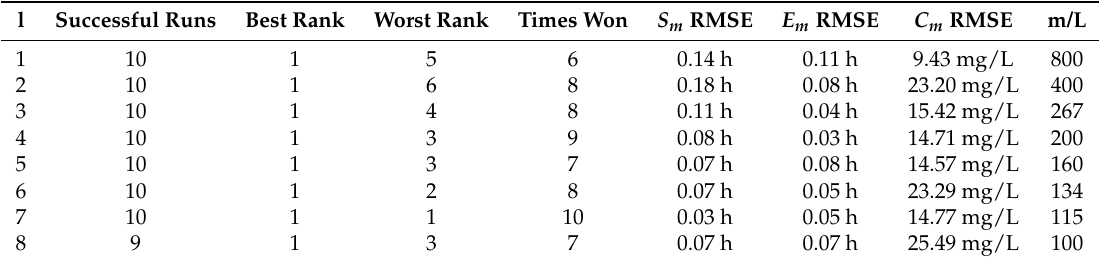
Table 9. Influence of the number of the tournament loops l on the accuracy and efficiency of the